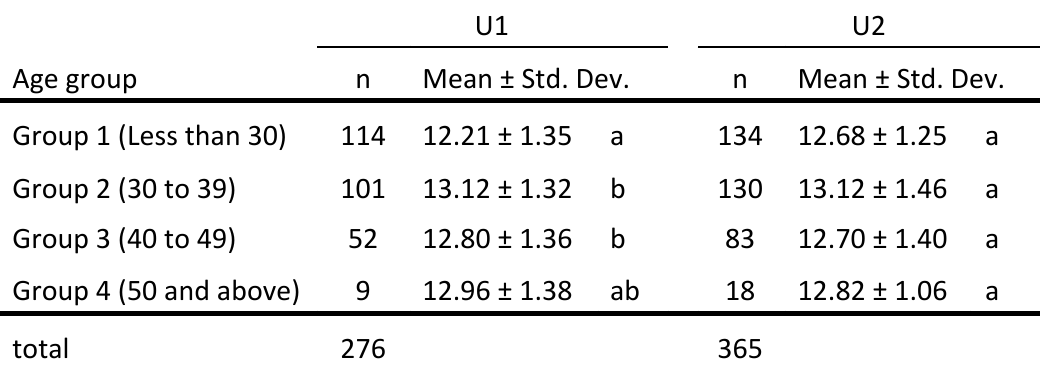
Table 1 – Average grades of 4 age groups of MS23 obtained from the registry databases of the universities U1 and